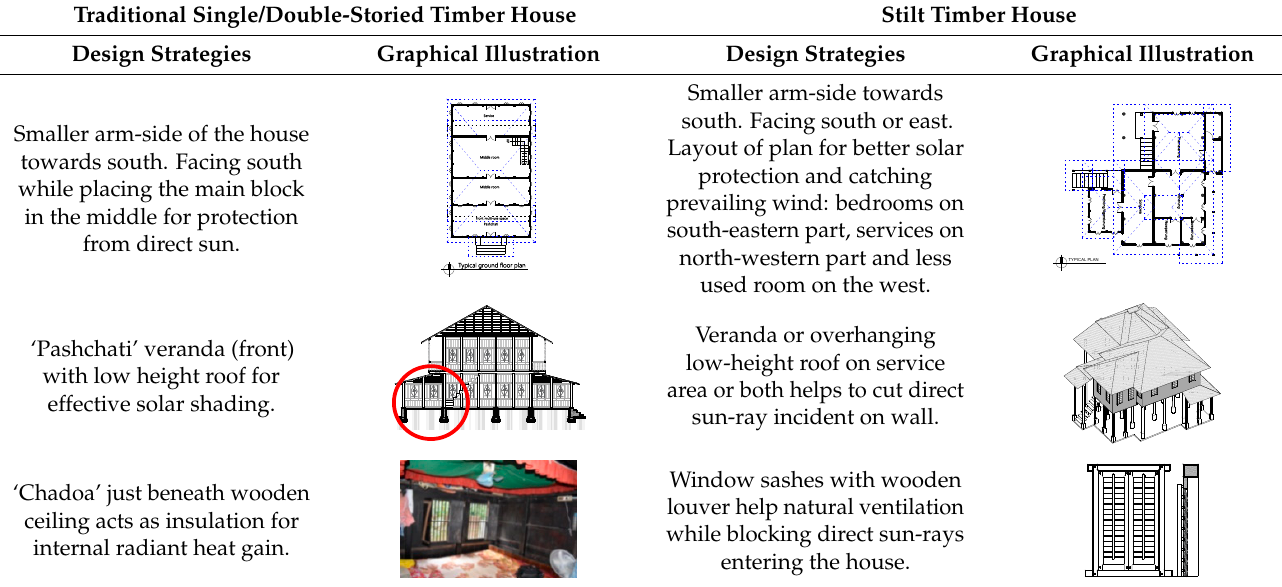
Table 5. Adopted passive design strategies related to indoor thermal environment.